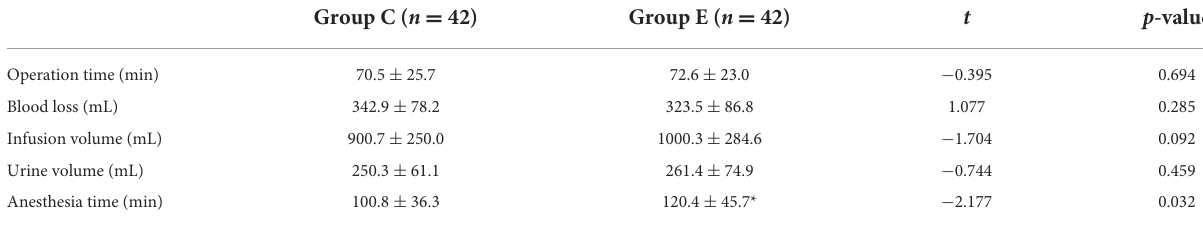
TABLE 7 Comparison of intraoperative conditions of the two groups.